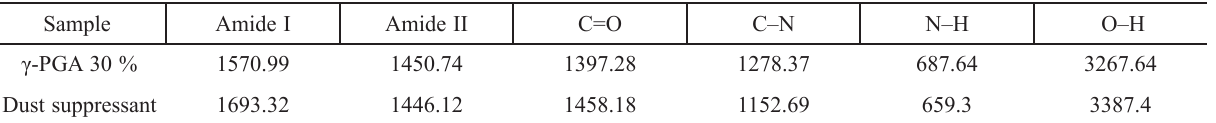
as reference material, and of the dust suppressant produced in this study